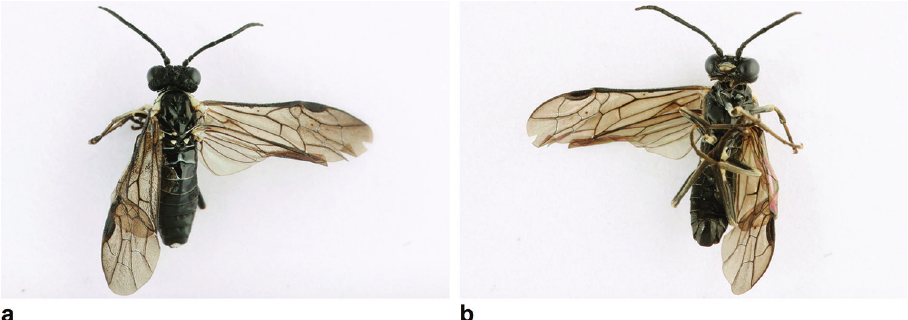
Figure 20. Stromboceridea albilabris , male (P4225), body length 7.0 mm. a Dorsal view b ventral view.